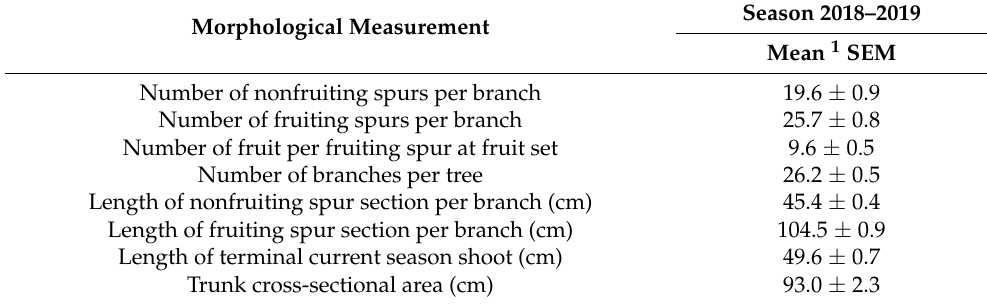
Table 2. Morphological characterization of individual vertical branches in the sweet cherry combina- tion ‘Lapins’/‘Colt’ trained as KGB during the 2018/19 growing season ( n = 80).